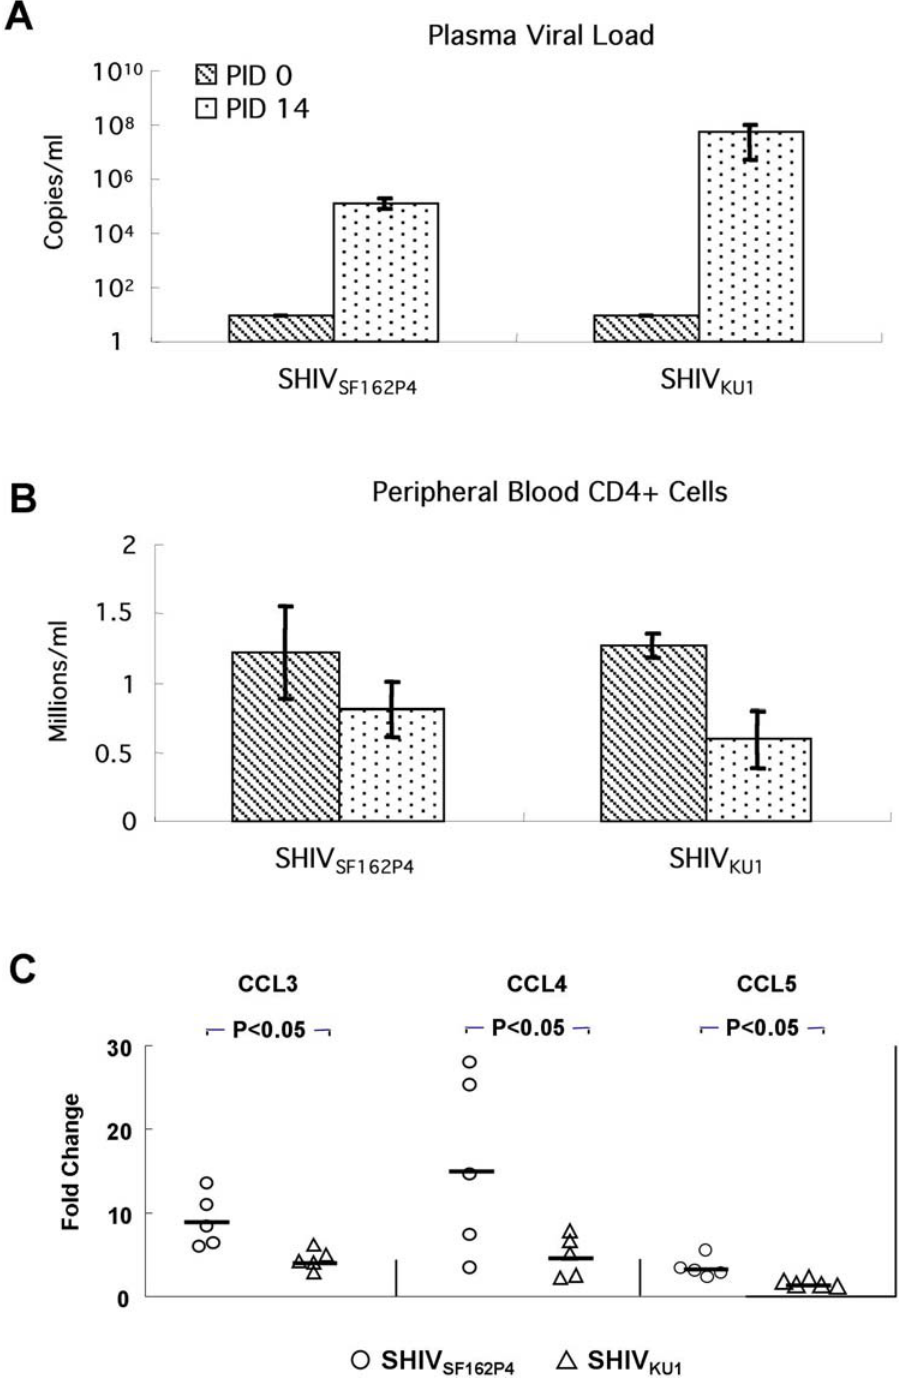
Figure 6. Comparison of SHIV SF162P4 and SHIV Ku1 primary infection in peripheral blood. Viral loads in plasma (A), CD4 + T cell counts (B), Fold- changes of CCL3, CCL4 and CCL5 gene expression levels in SHIV SF162P4 - and SHIV Ku1 –infected macaques at PID 0 vs. PID 14 (C) (n=5 for each group). Negative sample cut-off for viral load measurements in plasma was , 30 copies/ml e.g. PID 0 value.